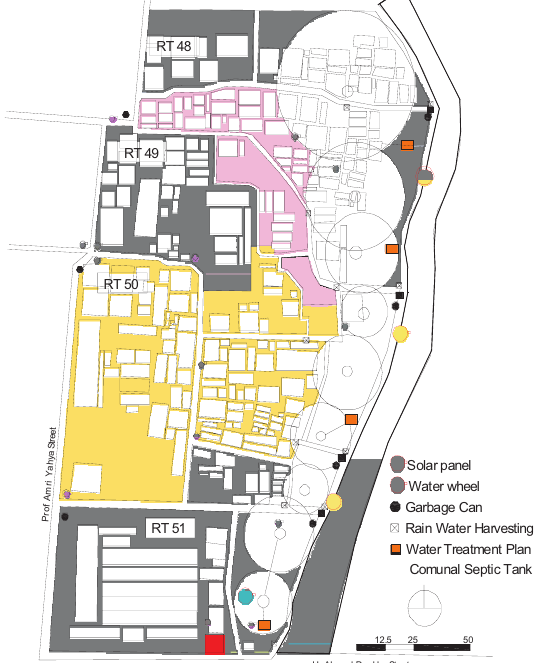
Figure 10. The sanitation, renewable energy and green concep of Kampong